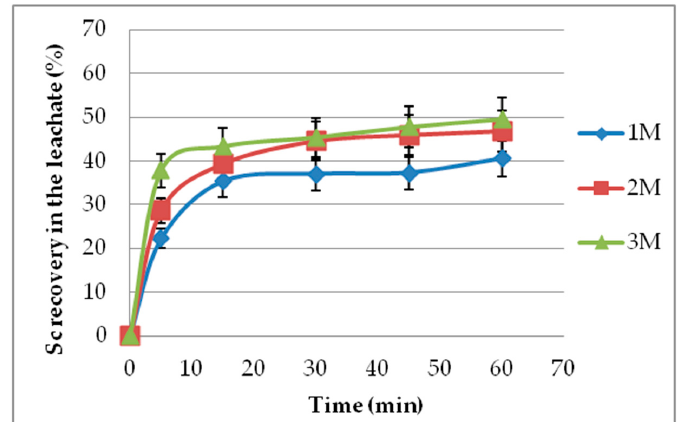
Figure 2. Leaching time effect on Sc recovery (%) for different acid molarities and an S/L of 5% (1:20).